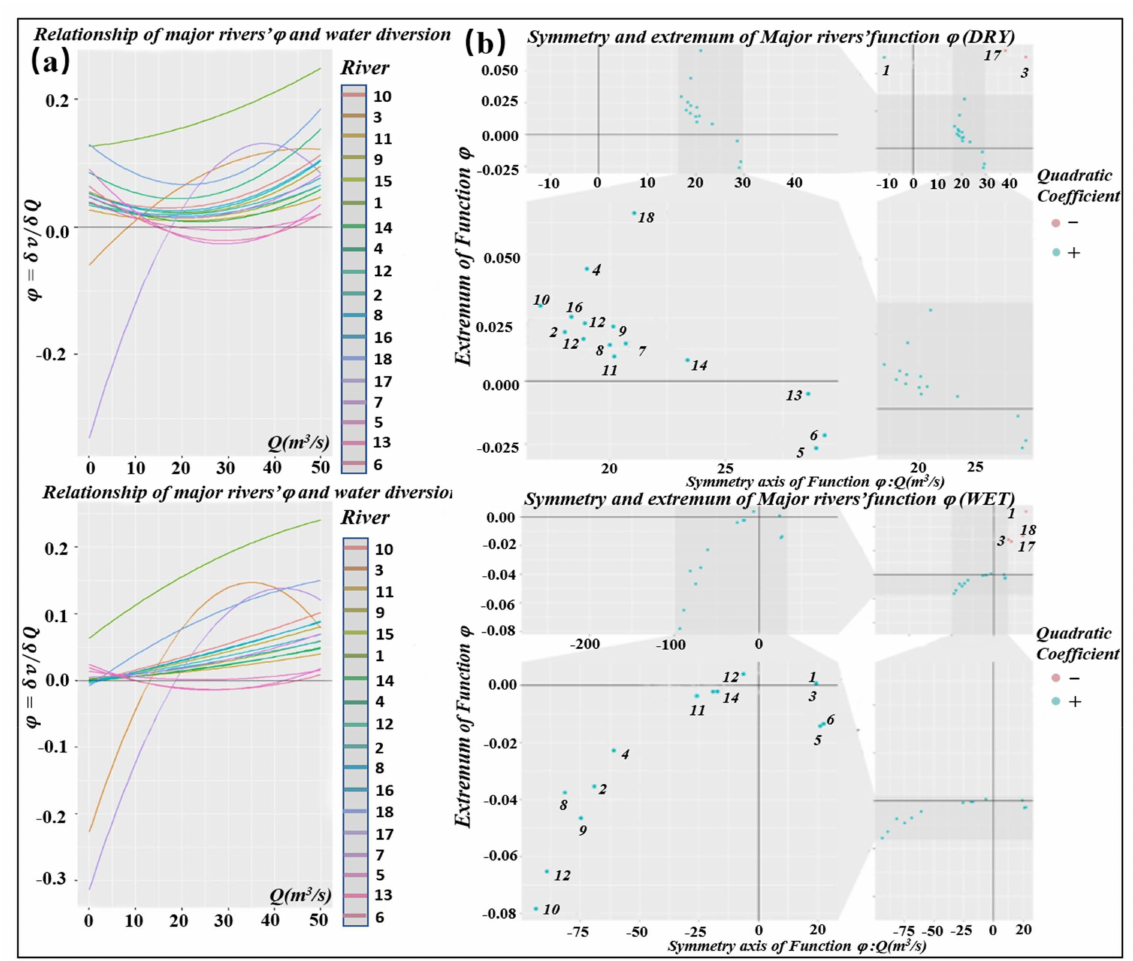
Figure 7. Effect of water diversion flux on flow velocity in river network. ( a ) The relationship between Q WDF and ϕ ; ( b ) Scatter plot of the vertices of the ϕ − Q